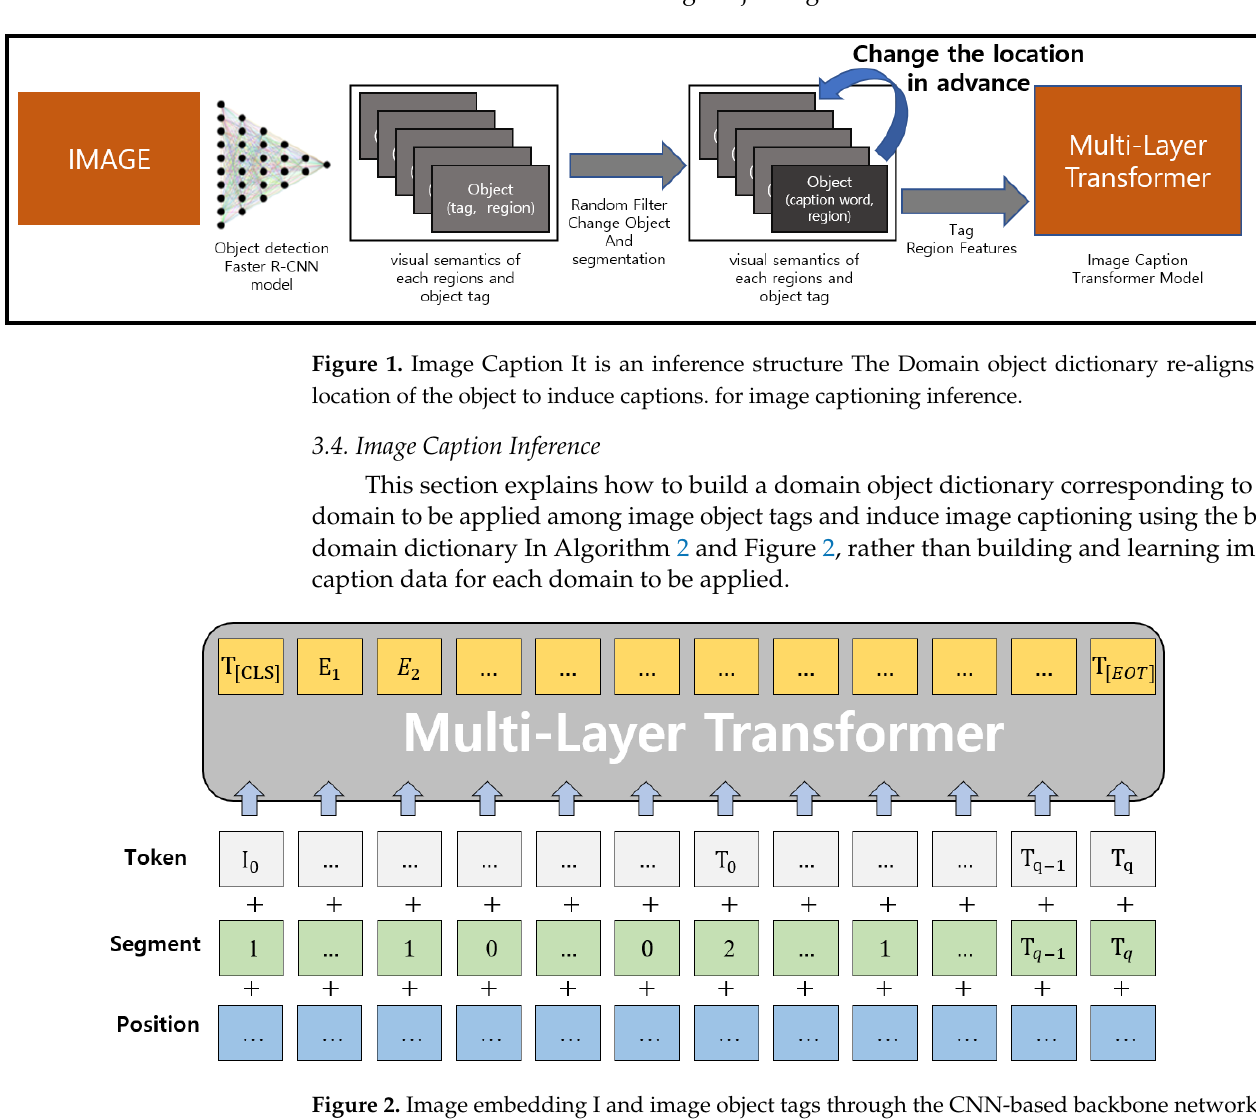
Figure 2. Image embedding I and image object tags through the CNN-based backbone network are input to the multi-layer transformer. To avoid overfitting, 30% of the tags generated and 5% of regular tags randomly change segment embedding to